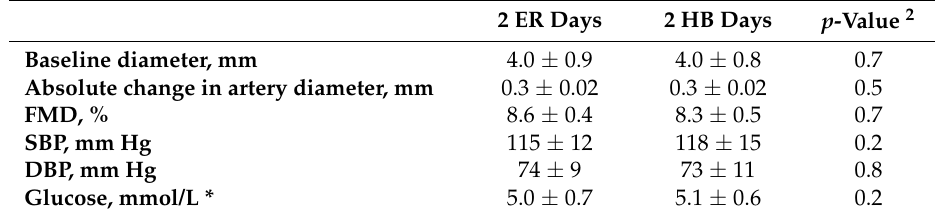
Table 3. All outcome variables for each eating state for compliers to the protocol 1